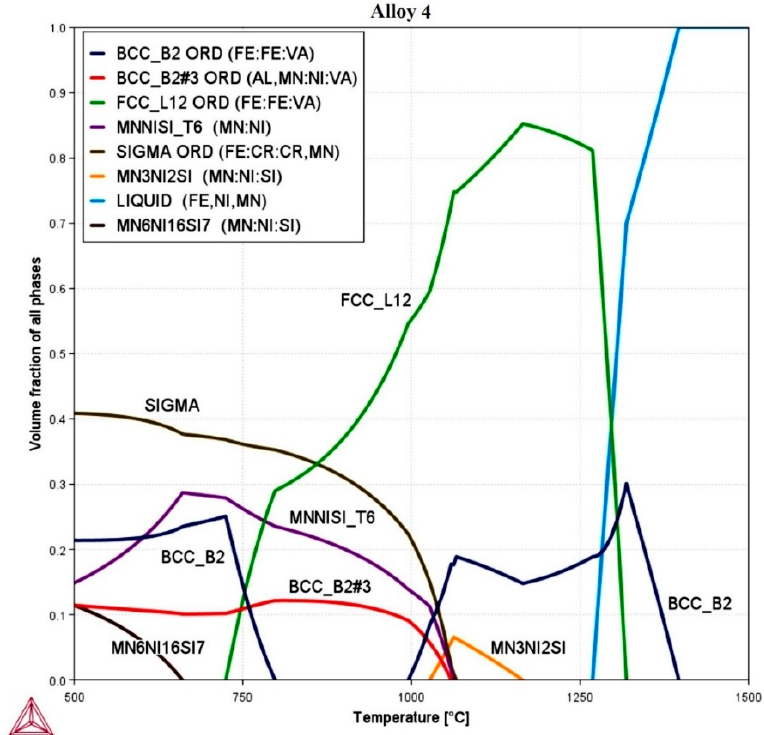
Figure 5. Phase diagram of Alloy 4 (Fe 35 Mn 20 Ni 20 Cr 15 Al 5 Si 5) HEA.